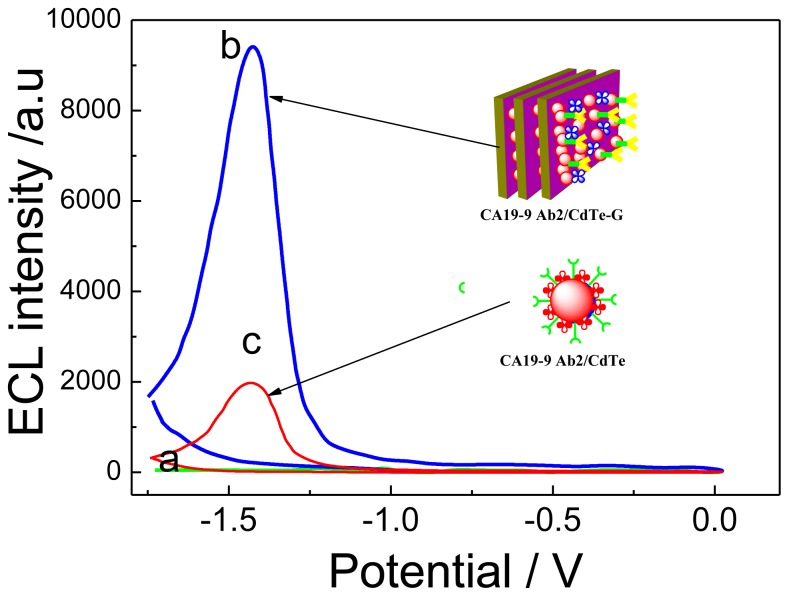
ECL-potential curves of the CA 19-9 Ab1/dextran-Fe3O4 modified SPCE electrode (a); (a) incubated in 10 pg/mL CA 19-9 + CA 19-9 Ab2/CdTe-G (b); (a) incubated in 10 pg/mL CA 19-9 + CA 19-9 Ab2/CdTe in 0.1 mol/L PBS (pH 7.0) containing 0.1 mol/L KCl and 0.1 mol/L K2S2O8 (c). The voltage of the photomultiplier tube was set at 600 V.